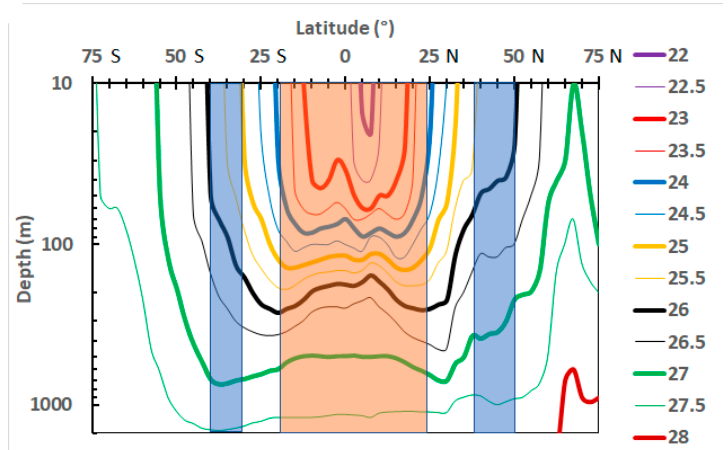
Figure 1. Isopycnals in the world ocean: ρ − 1 ( ρ = potential density) is represented with 0.5 kg m − 3 intervals. Zonal blue bands intersect the gyres in their part furthest from the equator; the zonal pink band intersects the gyres in their part closest to the equator [22].